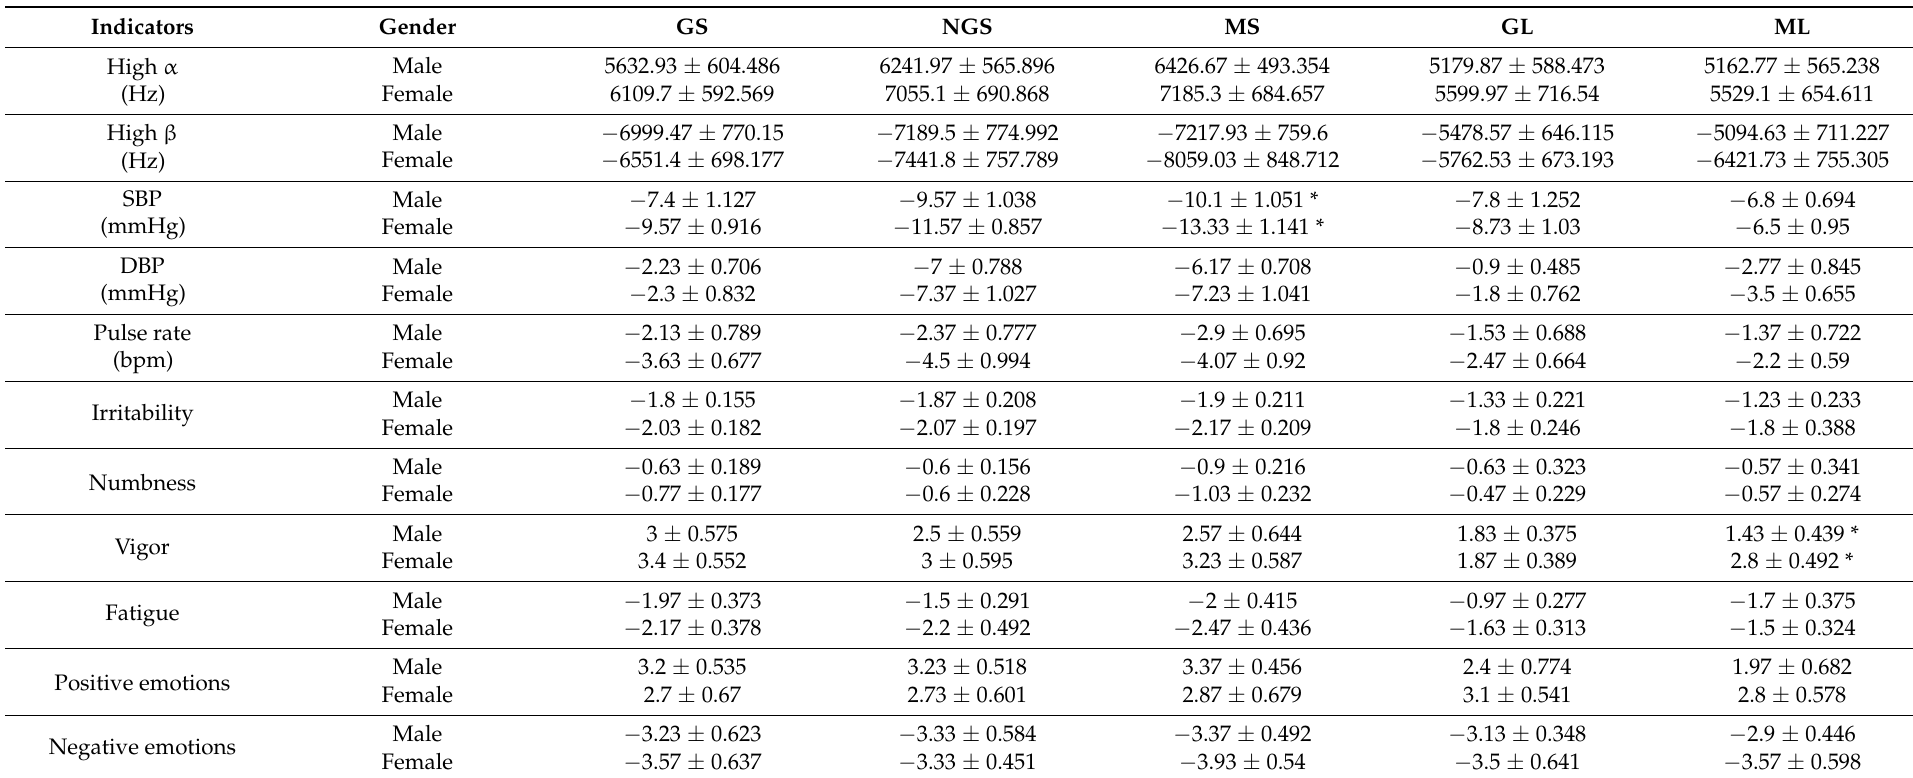
Table 1. Mean restorative value of psychophysiological responses of different genders for the five ornamental bamboo